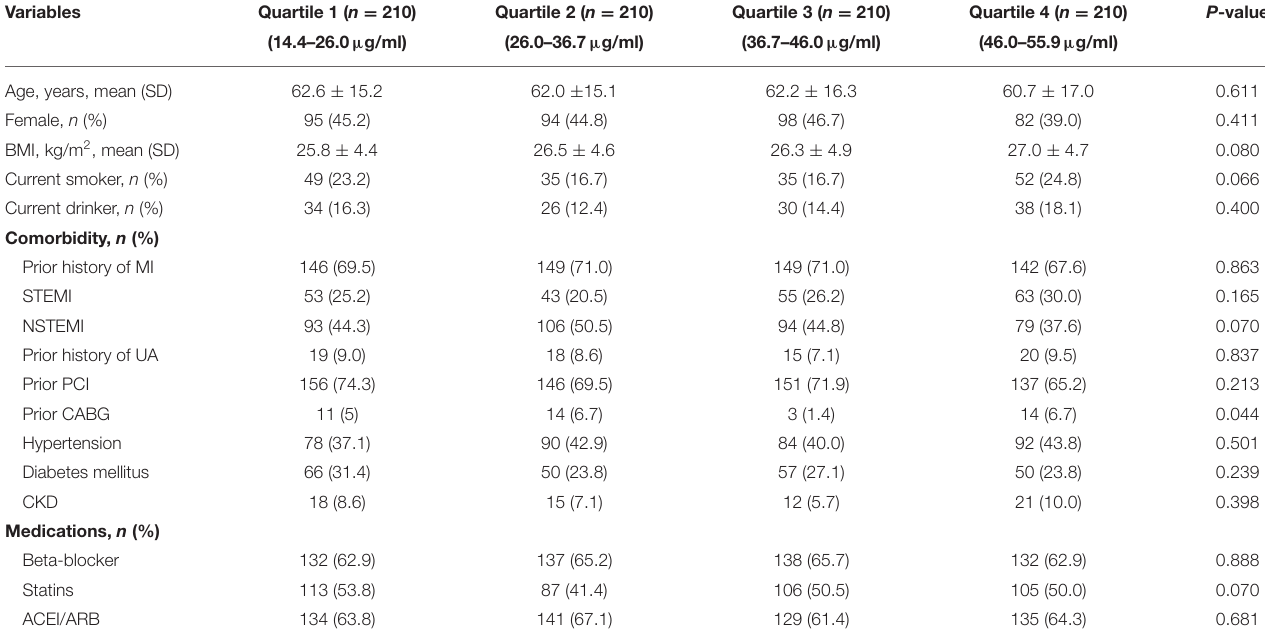
TABLE 1 | Baseline characteristics of patients according to circulating RBP4 concentration.